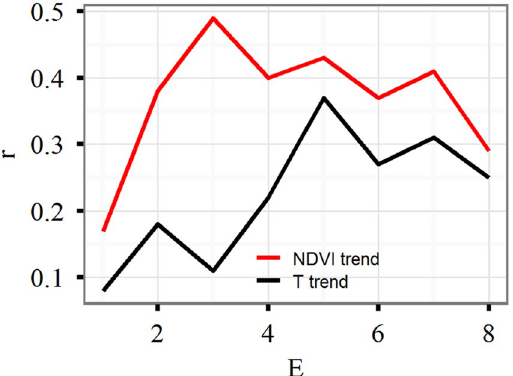
Figure 5. Prediction skill (correlation coefficient between actual and predicted values, r) as a function of the embedding dimension (E) using the simplex projection method of Sugihara and May 40